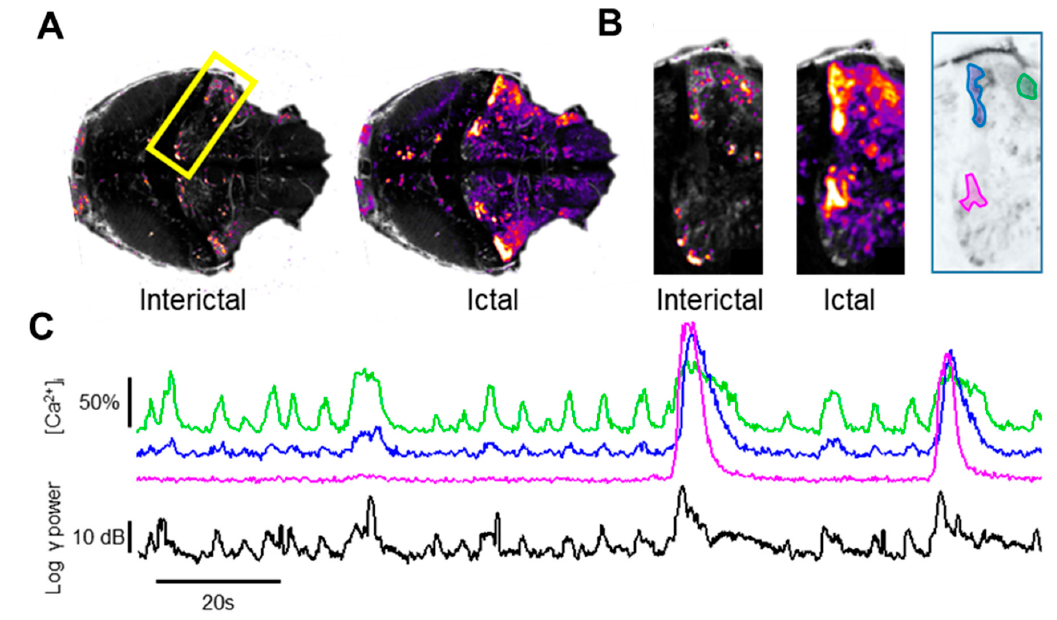
Figure 5 . Identification of the micro-circuitry associated with different epileptic-like events. ( A ) Cross-correlation maps computed during two different intervals in th presence of only interictal activity (left) or during large ictal events (right). The cross-correlation maps have been normalized to the respective maximum value. ( B ) Details of the Cb, as outlined by the yellow rectangle (300 µm high) in panel A, showing the different sources of LFP signal during these two different classes of events. The finder map on the right shows three areas belonging to the cerebellum that are differentially active during interictal and ictal-like events. ( C ) Δ F/F0 measured in the three areas outlined by the corresponding colors in B. While all areas respond to the three large ictal events, the neuronal territory involved in interictal activity (green area and trace) is far more limited.